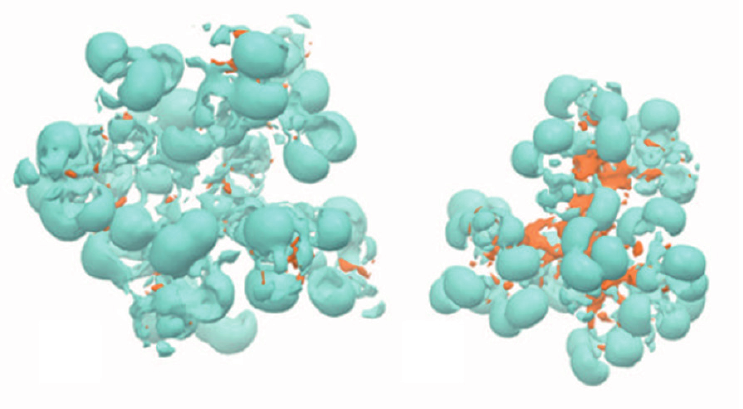
Figure 9. PAMAM dendrimers’ hydrophilic surface (blue) and hydrophobic core (orange). Adapted from